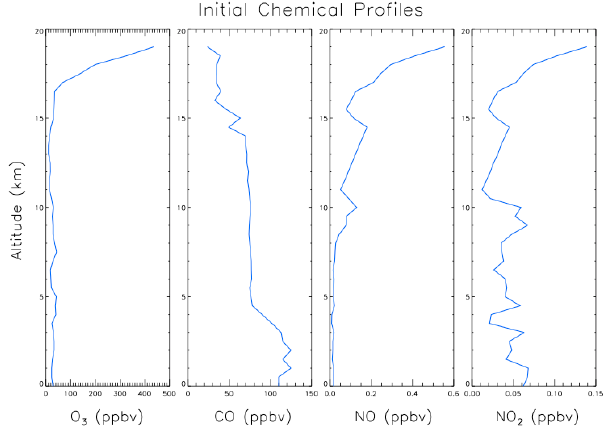
Fig. 4. Initial chemical profiles based on composite of Dornier, Fal- con, Geophysica, and Egrett measurements.